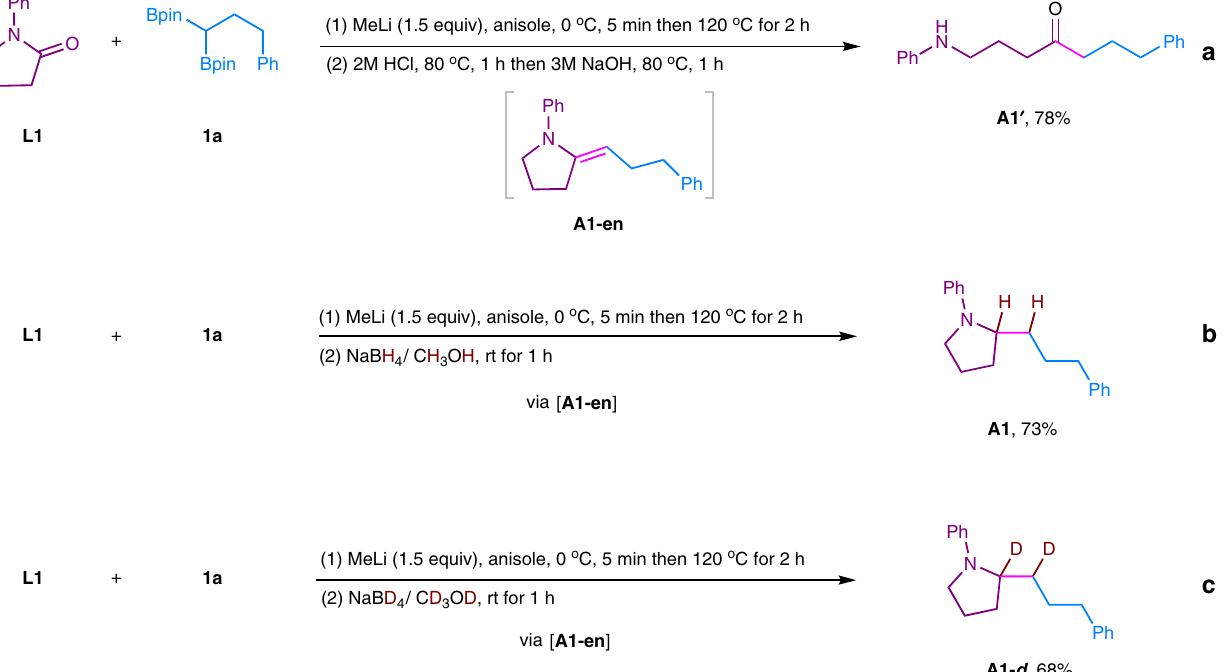
Fig. 8 Investigation for the transformation of lactam. a Hydrolysis for the reaction of lactam L1 with 1a . b Reduction for the reaction of lactam L1 with 1a using NaBH 4 . c Reduction for the reaction of lactam L1 with 1a using NaBD 4